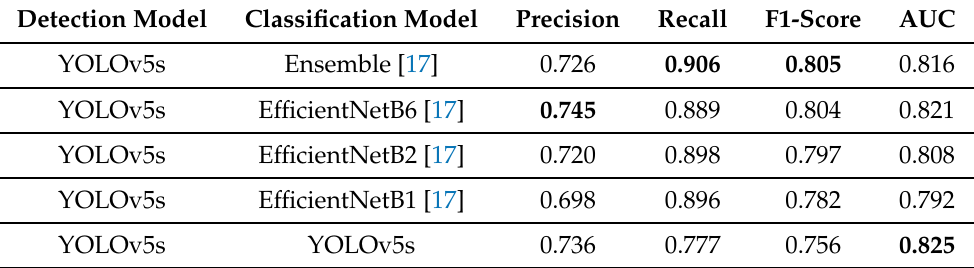
Table 4. Results of the object’s classification.